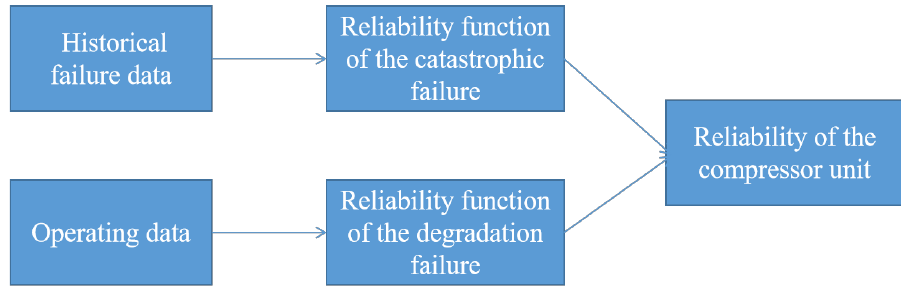
Figure 2. Block diagram of the stages of reliability analysis of the natural gas compressor.